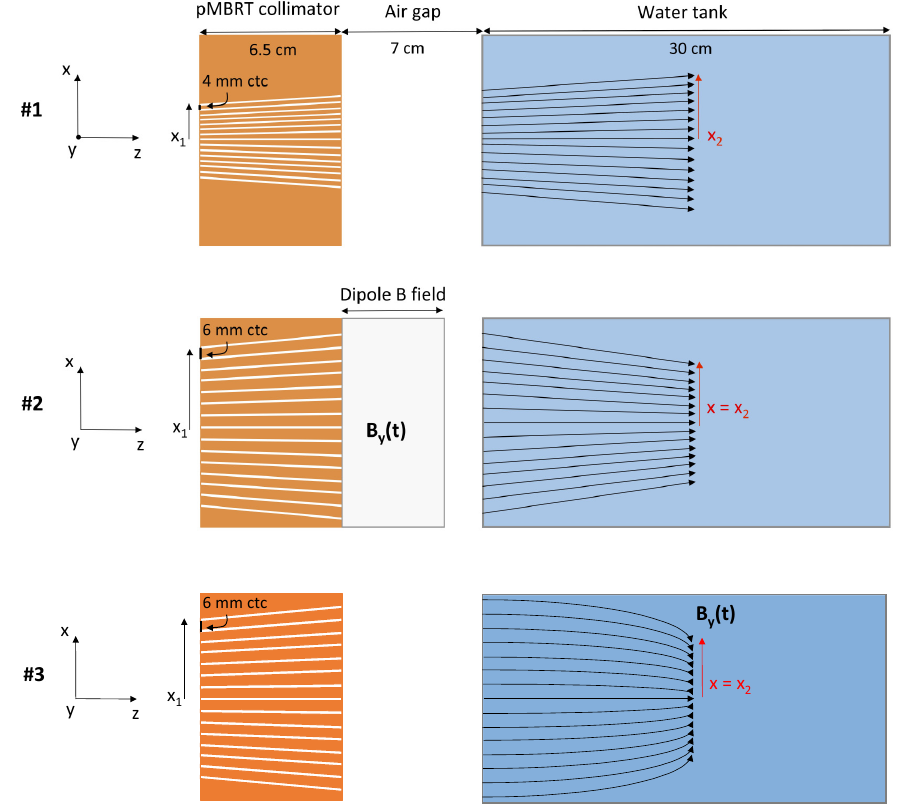
Figure 1. Schematic drawing of the configurations of magnetic field and collimator used in the study. In all configurations, the entrance surface of the water phantom was placed at 7 cm from the collimator rear surface and a PBS grid aligned with the slit position was